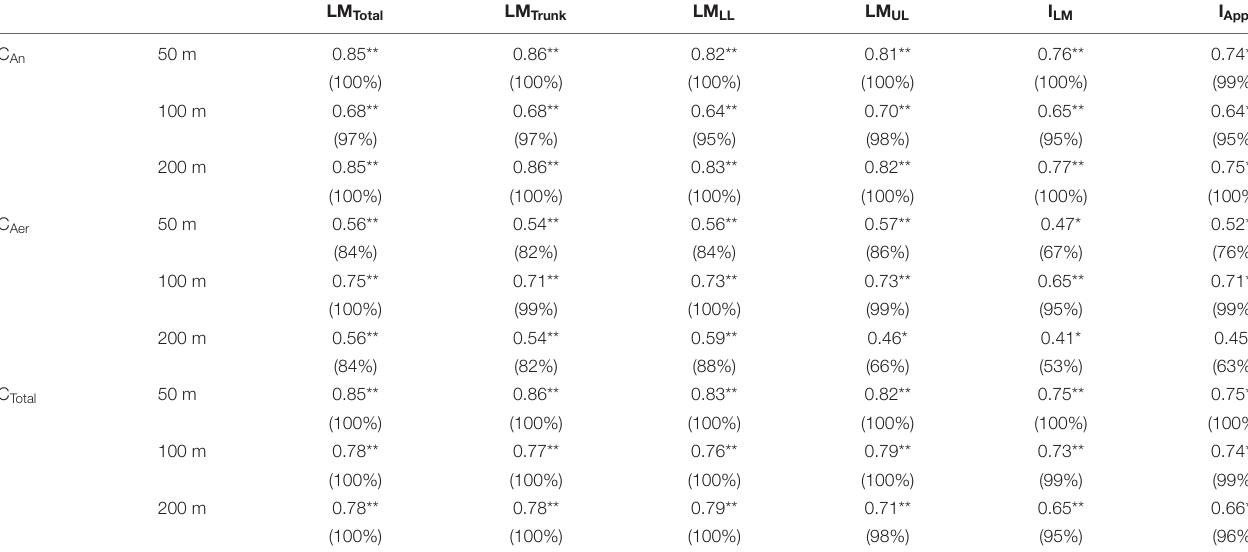
TABLE 2 | Relationship between body composition variables and values of C An , C Aer , and C Total for the 50, 100, and 200 m. LM Total LM Trunk LM